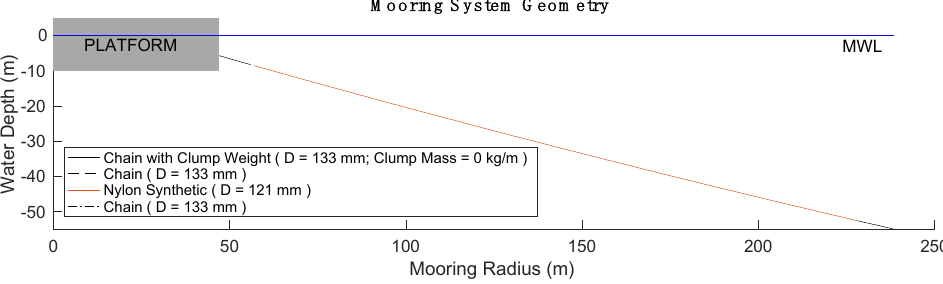
Figure 15. Illustration of the Optimized Candidate Design for the VolturnUS 6-MW Turbine. The candidate design mooring system is described in Table 10. As outlined in the optimization problem description, this mooring system has three mooring lines spaced equally with each line fairlead connected to one of the outer columns on the VolturnUS 6-MW hull. This mooring system has 10 m of 133 mm diameter chain at the fairlead and anchor with a 167 m long length of 121 mm diameter synthetic spanning between the two chain segments. The fairlead attachments are situated 5.4 m below the water connected to the radius of the outer columns 45.7 m away from the center of the platform. Table 10. VolturnUS 6-MW Optimized Candidate Design. Number of mooring lines 3 Angle of mooring lines (0 ◦ aligned with positive surge axis) 60 ◦ , 180 ◦ , 300